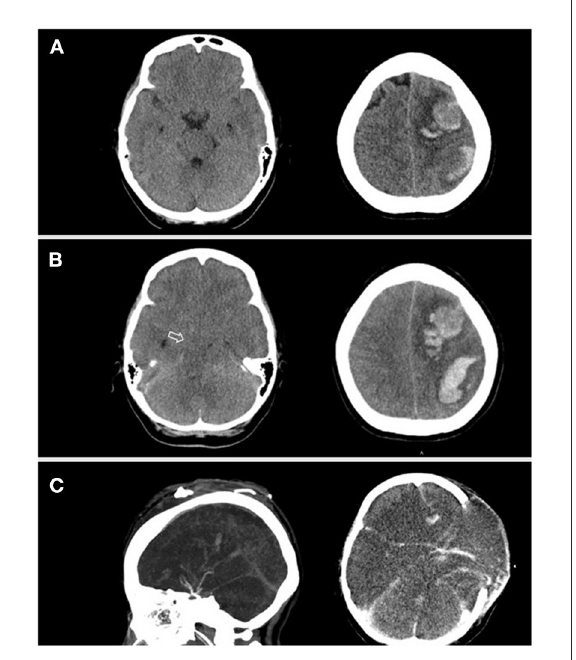
FIGURE1 A series of brain CT over the disease course. (A) Brain CT revealed two lobar hemorrhages located in the left frontal and parietal lobes with perifocal edema. (B) Five hours later, the patient’s brainstem reflex was lost, and brain CT showed progressive hemorrhage with diffuse cerebral edema and bilateral uncal herniation (arrow). (C) Contrast-enhanced brain CT obtained 5 days after craniectomy showed suboptimal vascular image quality due to prominent intracranial